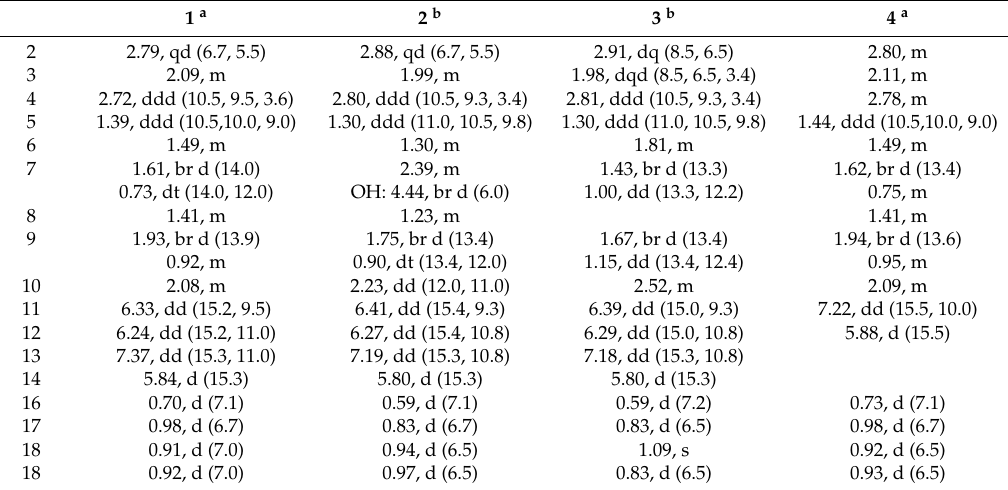
Table 2. 1 H chemical shifts (700 MHz) of elsinopirins A–D ( 1 – 4